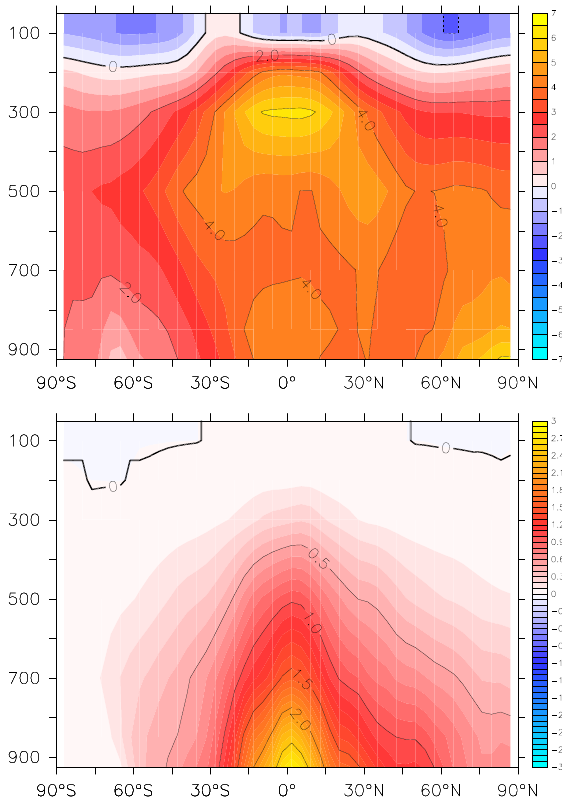
Fig. 21. The difference of the zonal mean air temperature in K (top) and zonal mean specific humidity in 10 − 3 kgkg − 1 (bottom) of the 2 × CO 2 experiment and the control run.